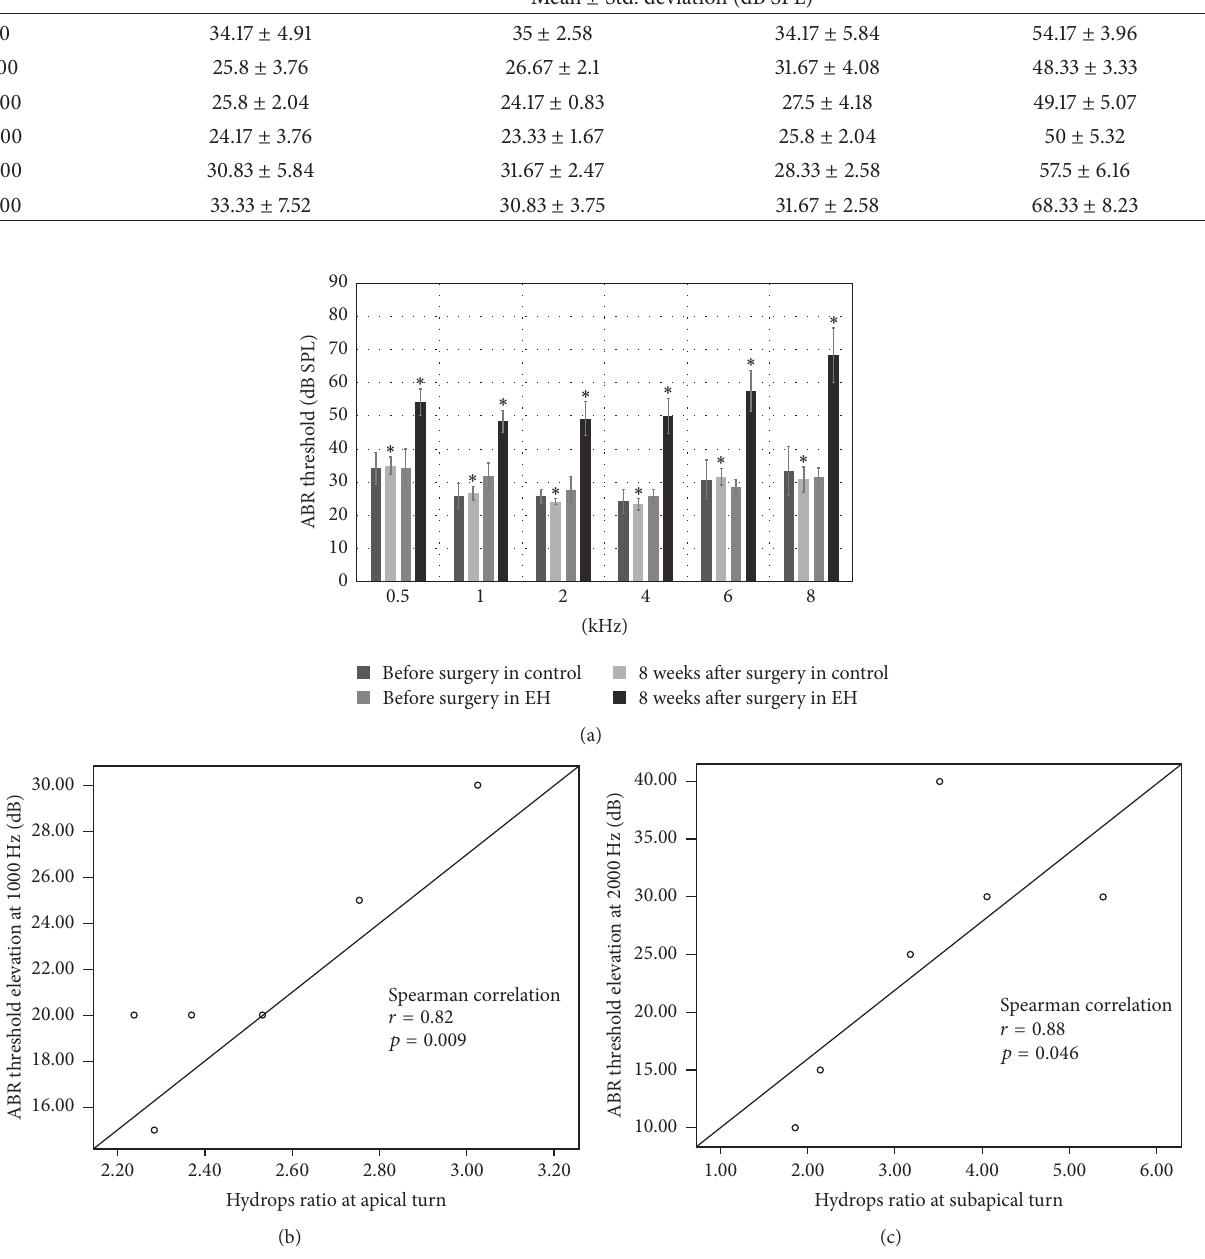
Figure 4: (a) The mean thresholds of ABR were recorded before surgery and 8 weeks after surgery in control and EH group. The mean ABR threshold of the EH cases was significantly higher than that of the control group at 0.5, 1, 2, 4, 6, and 8 kHz ( ∗ 𝑝 < 0.05 ) 8 weeks after surgery. (b) Correlation between HR at apical turn and ABR threshold elevation at 1 kHz. (c) Correlation between HR at subapical turn and ABR threshold elevation at 2